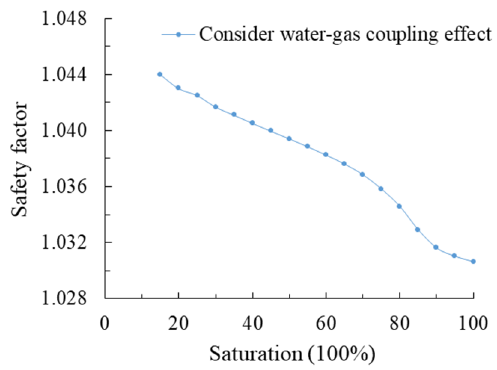
Figure 17. Evolution of safety factor with saturation degree.